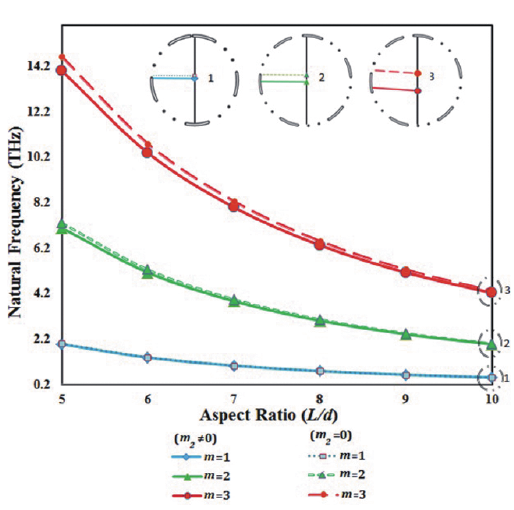
Fig. 2. Change of natural frequency with aspect ratio L/d for different change in nonlocal